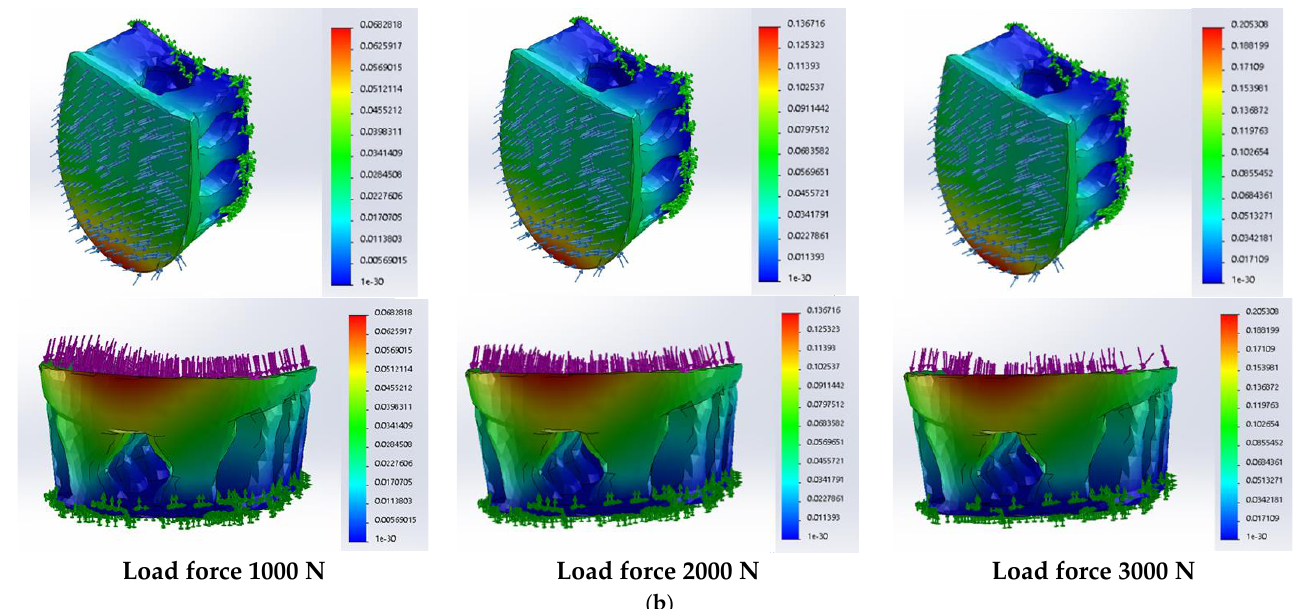
Figure 5. Results of the static analysis of designed orthopedic shoe heels from NYLON: ( a ) distribution of the von Mises stress, MPa; ( b ) distribution of the displacements, mm.